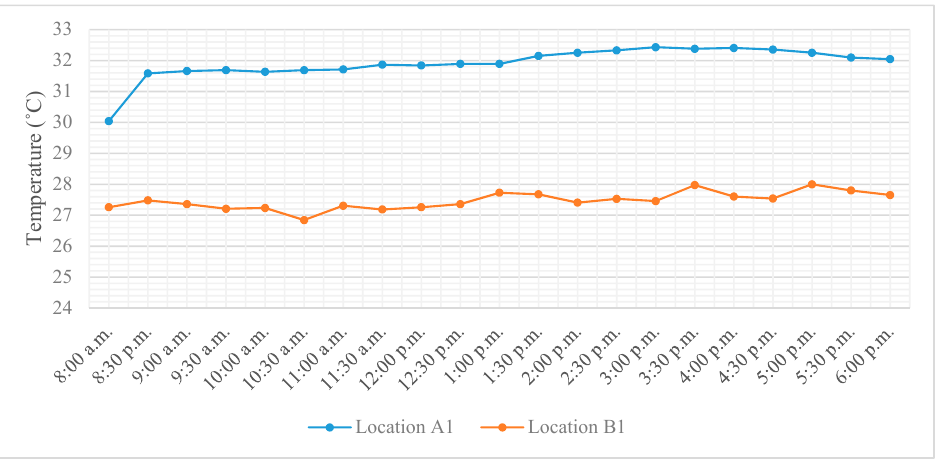
Figure 11. Indoor air temperature in the lobby of Building A (Location A1) and Building B (Location B1). Relative humidity (RH) also plays an important role in achieving indoor comfort. As shown in Figure 12, location A1 and B1 started the day with the highest level of RH. RH at location A1 started